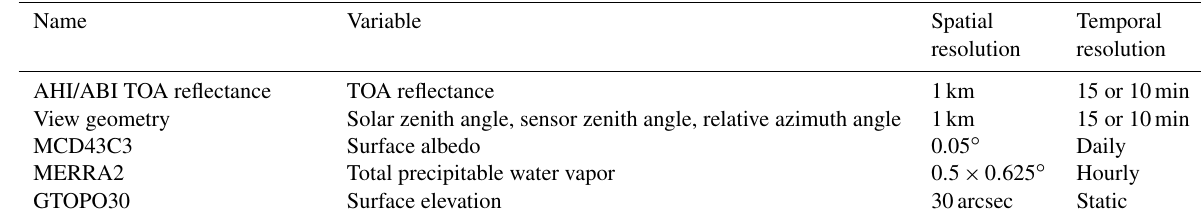
Table 1. The summary of input data.